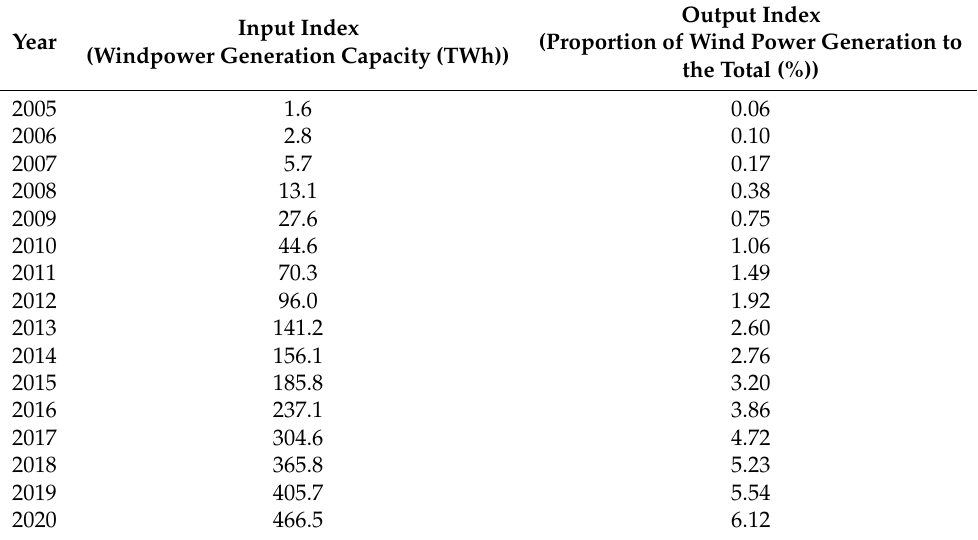
Table 4. Input–output indexes of wind power utilization